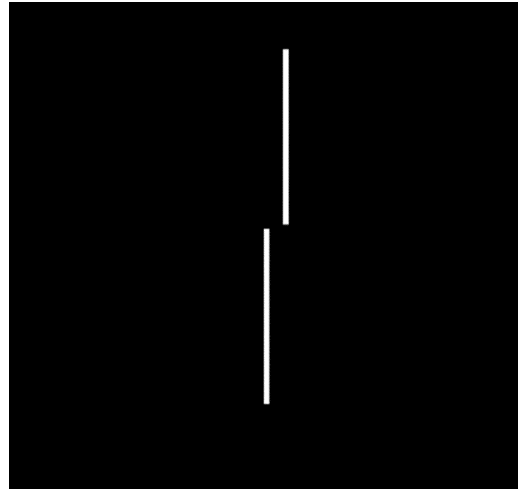
Figure 4. Vernier’s stimulus.